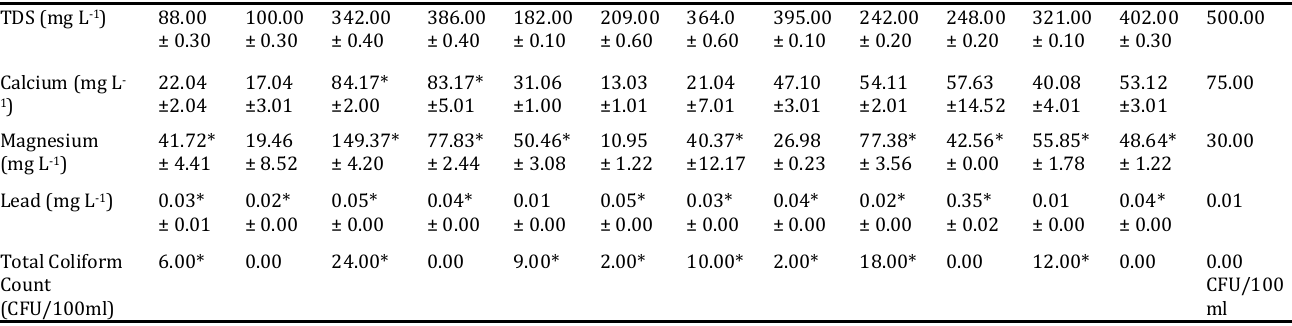
Table 2: Daily intake of metal (DIM) Pb for Adult, Health risk index (HRI) and Target cancer risk (TR)